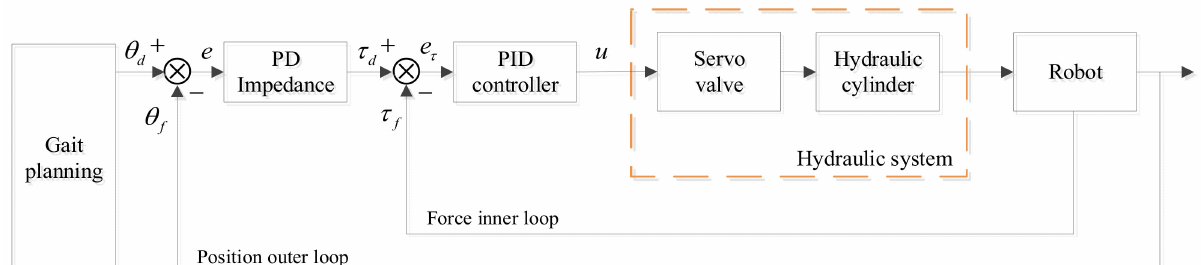
Figure 10. The block diagram of impedance